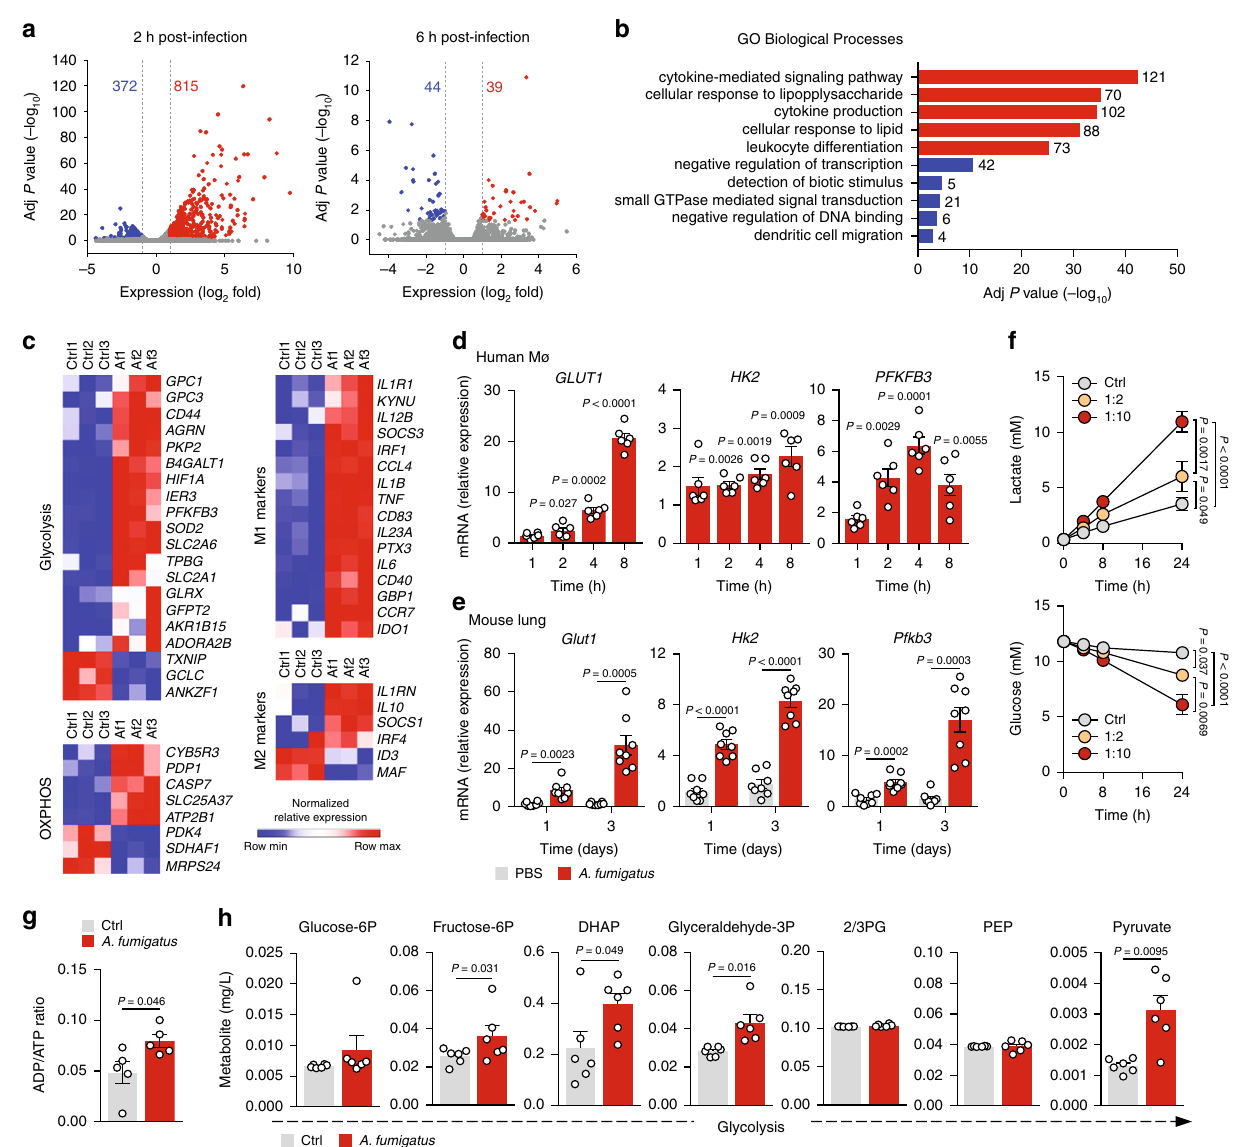
Fig. 1 A. fumigatus induces glycolysis in macrophages. a Transcriptome analysis of human macrophages infected with A. fumigatus for 2 or 6 h. Numbers indicate genes with differential expression, up- (red) or downregulated (blue) in infected relative to uninfected cells. b Pathway analysis of up- (red) or downregulated (blue) genes 2 h after infection. Genes were categorized into the most represented pathways, in which the gene products are involved. c Transcriptional pro fi les of macrophages left untreated (Ctrl) or infected with A. fumigatus (Af) for 2 h ( n = 3). Expression of genes is presented as centered, and scaled log 2 fl uorescence intensity (blue and red keys) grouped by product function. d mRNA expression of GLUT1 , HK2 , and PFKFB3 in macrophages infected for 1, 2, 4, or 8 h relative to uninfected cells ( n = 6). e mRNA expression of Glut1 , Hk2 , and Pfkfb3 in mouse lungs sampled 1 or 3 days after infection ( n = 8, representative of three independent experiments). f Lactate secretion and glucose consumption by macrophages left untreated or infected at 1:2 or 1:10 for 24 h ( n = 6). g ADP/ATP ratio ( n = 5) and h targeted metabolomics ( n = 6) in macrophages left untreated or infected for 6 h. Data are expressed as mean values ± SEM. P -values were calculated using Student ’ s two-tailed t test or two-way ANOVA with Tukey ’ s multiple comparisons